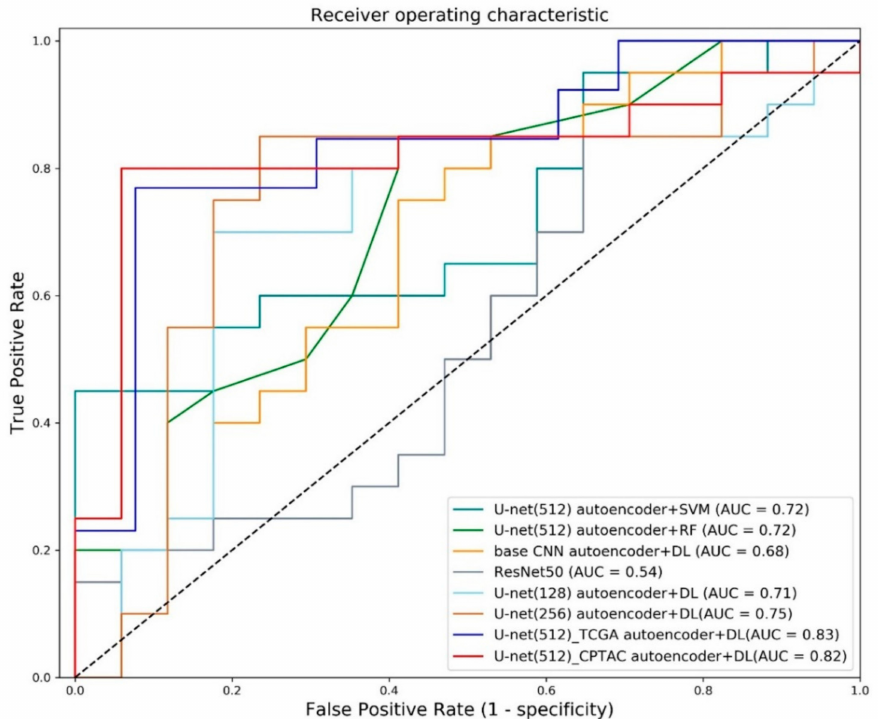
Figure 4. Receiver operating characteristic curve. ROC curves of various models. Curves correspond to SVM with latent variable of U-net (512) autoencoder, random forest with latent variable of U-net (512) autoencoder, deep learning classifier with latent variable of basic CNN reconstruction, single- stage ResNet50, deep learning classifier with latent variable from U-net (128), deep learning classifier with latent variable from U-net (256) and deep learning classifier with latent variable of U-net (512) autoencoder. The AUC of our methods is higher than others in both test cohorts.